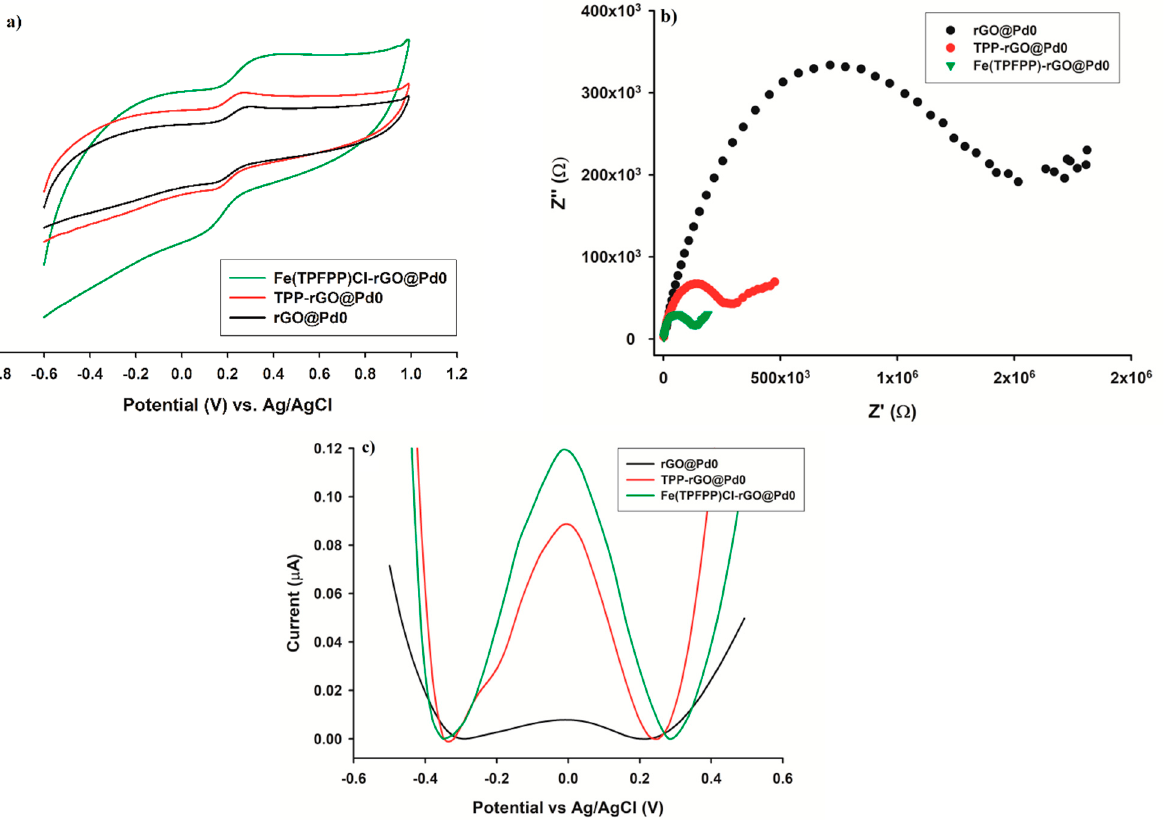
Figure 1. ( a ) Cyclic voltammograms of the current plotted against the potential (working conditions: step potential 0.025 V and scan rate 0.1 V s − 1 ) in a solution of 5.0 × 10 − 3 mol L − 1 K 3 [Fe(CN) 6 ] (0.1 mol L − 1 KCl) using the rGO@Pd0 (black line), TPP/rGO@Pd0 (red line), and Fe(TPFPP)Cl/rGO@Pd0 (green line). ( b ) Electrochemical impedance spectra recorded for rGO@Pd0 (black line), TPP/rGO@Pd0 (red line), and Fe(TPFPP)Cl/rGO@Pd0 (green line) in a solution of 5.0 × 10 − 3 mol L − 1 K 3 [Fe(CN) 6 ] (0.1 mol L − 1 KCl (conditions: frequency range between 1.0 × 10 5 and 1.0 × 10 − 1 Hz). Inset: equivalent circuit diagram of the electrochemical interface used to fit the impedance spectra where Rs is the solution resistance, CPE is the constant phase element, Rct is the electron-transfer resistance, and W is the Warburg diffusion resistance. ( c ) The recorded square wave voltammograms in PBS pH 4.5 containing 1.0 × 10 − 7 mol L − 1 Na 2 S 2 O 5 for rGO@Pd0 (black line), TPP/rGO@Pd0 (red line) and Fe(TPFPP)Cl/rGO@Pd0 (green line); working conditions: step potential, 0.03 V; amplitude, 0.1 V; and frequency, 10 Hz.